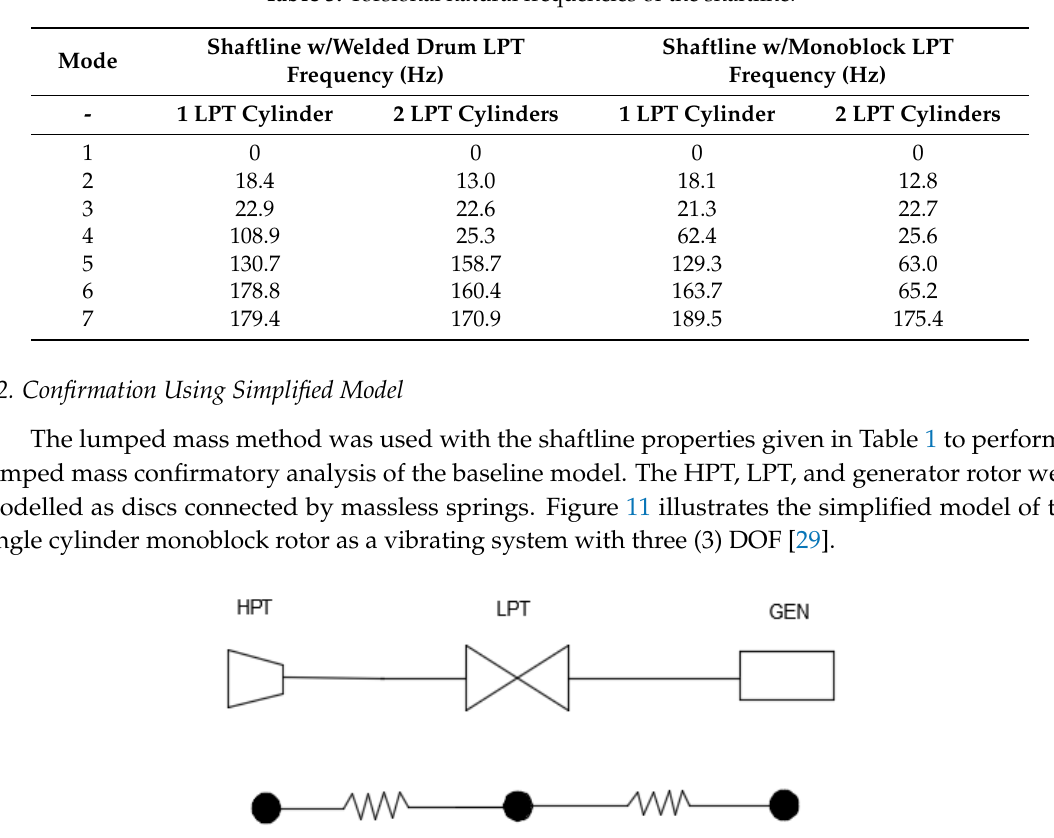
Table 4. Torsional parameter formulae [29].